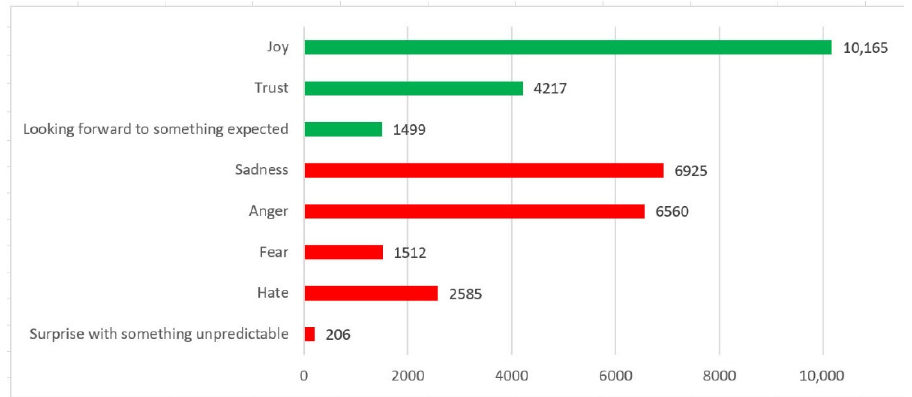
Figure 10. Users’ emotions detected by sentiment analysis. Green—positive, red—negative.